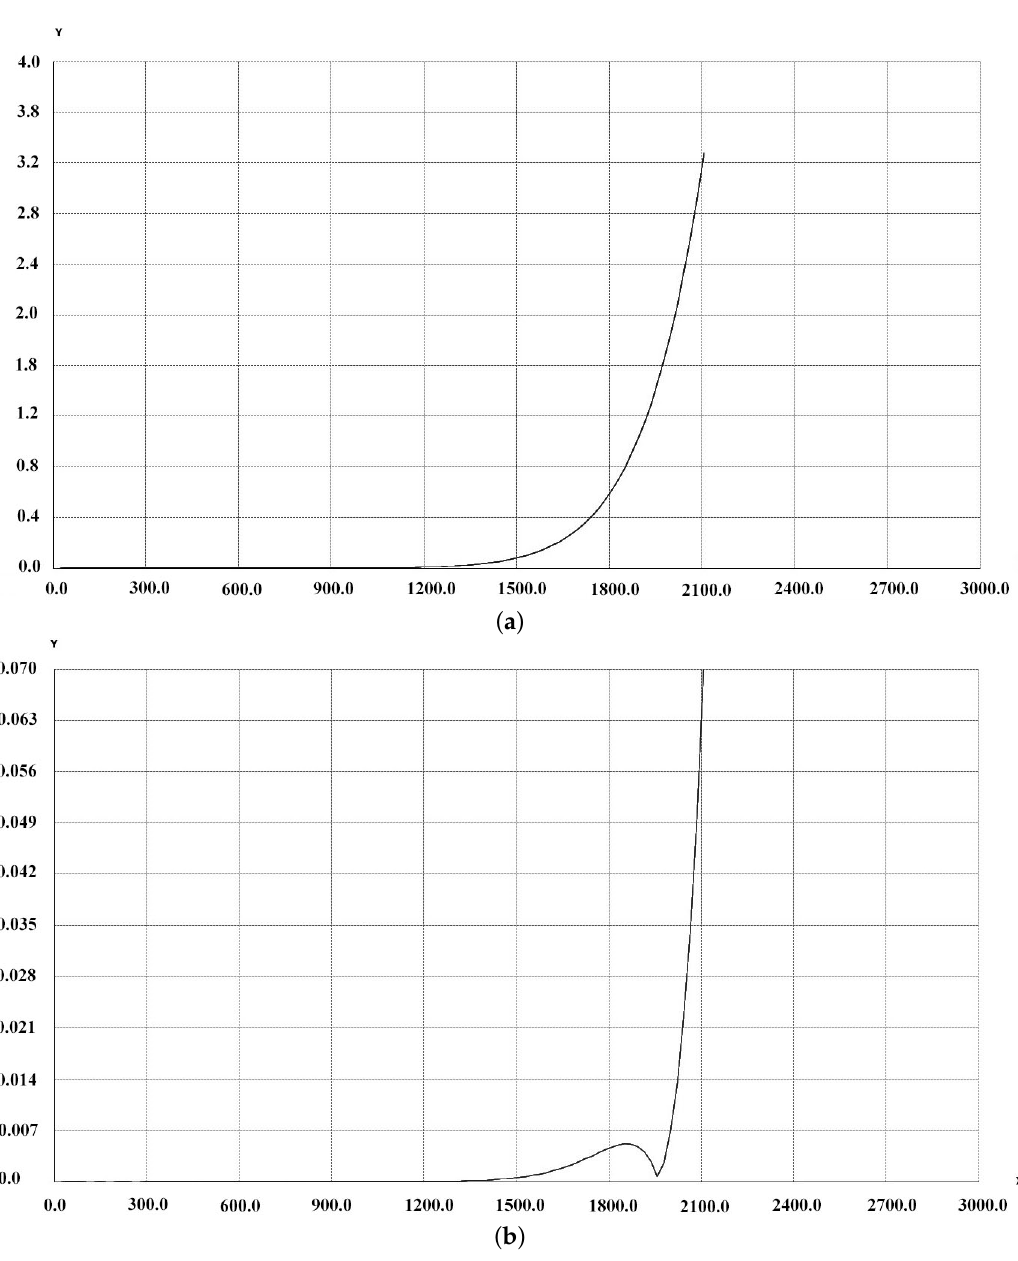
Figure 4. Inverse residual distortion with k 1 .. k 9 Coefficient Computed for the entire frame. ( a ) Inverse residual distortion with k 1 ... k 4 Coefficient Computed from 0 to max X frame; ( b ) Inverse residual distortion with k 1 .. k 9 Coefficient Computed from 0 to max X